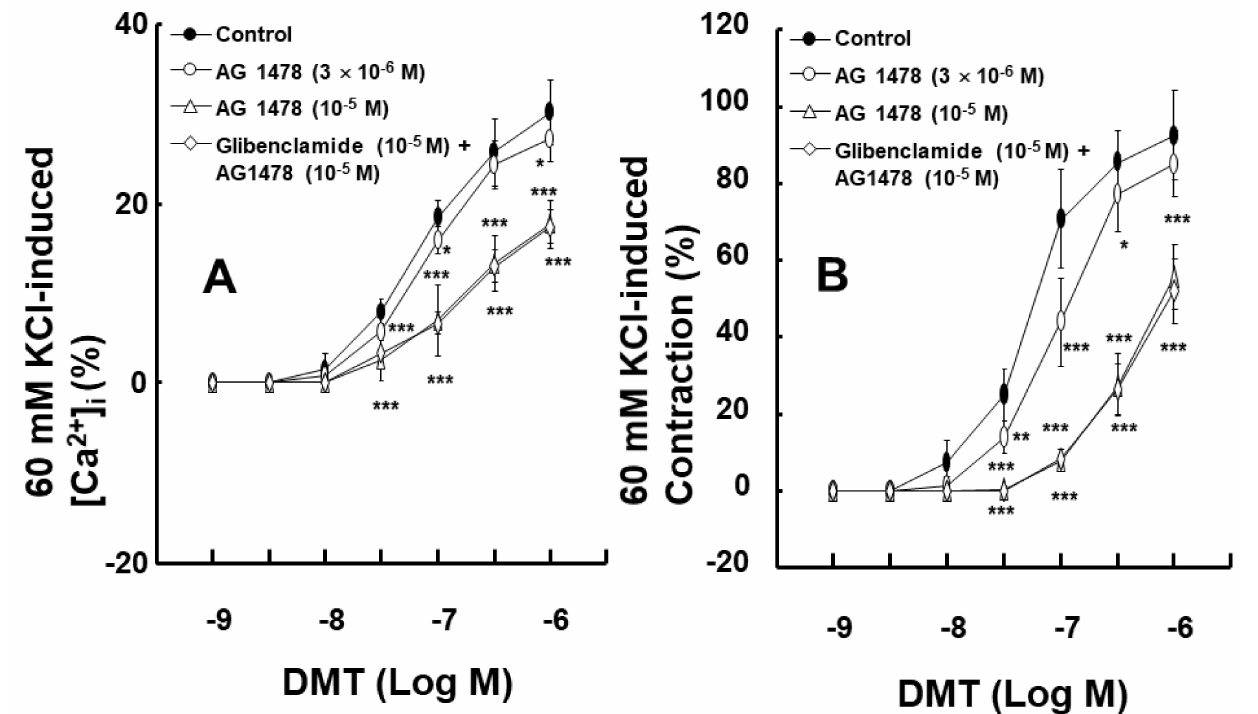
Figure 6. Effects of AG1478 alone and the combined treatment with glibenclamide and AG1478 on the intracellular calcium level ([Ca 2+ ] i ) ( A ) and contraction ( B ) induced by dexmedetomidine (DMT) in endothelium-denuded aortic strips loaded with Fura-2. The [Ca 2+ ] i and contraction induced by DMT are expressed as a percentage of [Ca 2+ ] i and contraction induced by 60 mM KCl, respectively. Data (N = 5) are shown as mean ± SD. N indicates the number of independent experiments. Control indicates no treatment. * p < 0.05, ** p < 0.01, and *** p < 0.001 versus